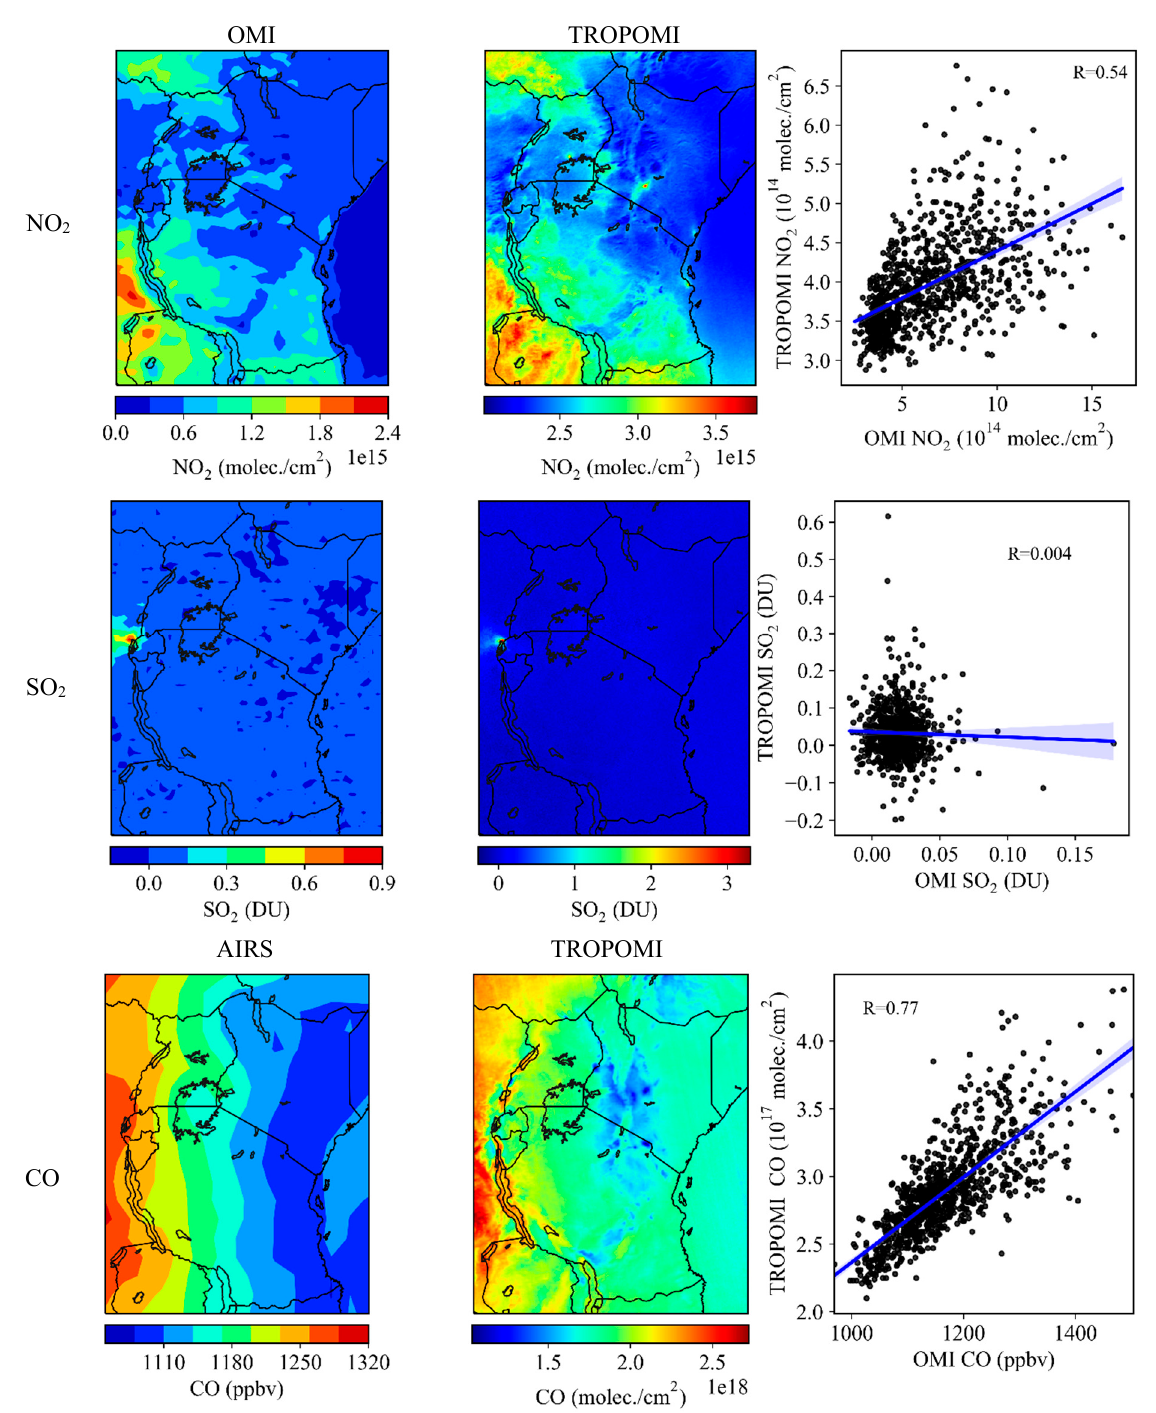
Figure 2. Spatial distribution of NO 2 , SO 2 and CO as observed by OMI, AIRS and TROPOMI along with the correlations between the instrument records.